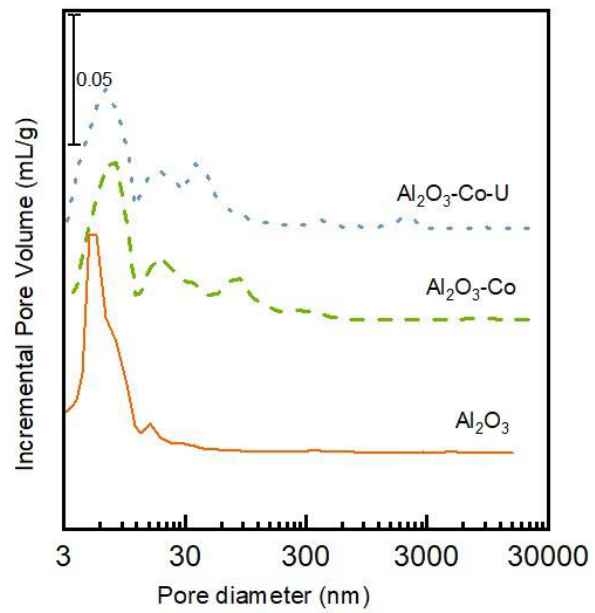
Figure A1. Pore distribution of Al 2 O 3 support, fresh and used cobalt catalyst.